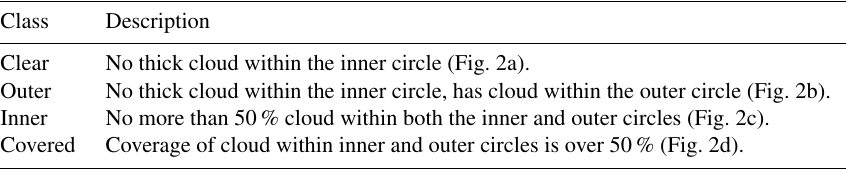
Table 1. The ASC image classes and corresponding description.